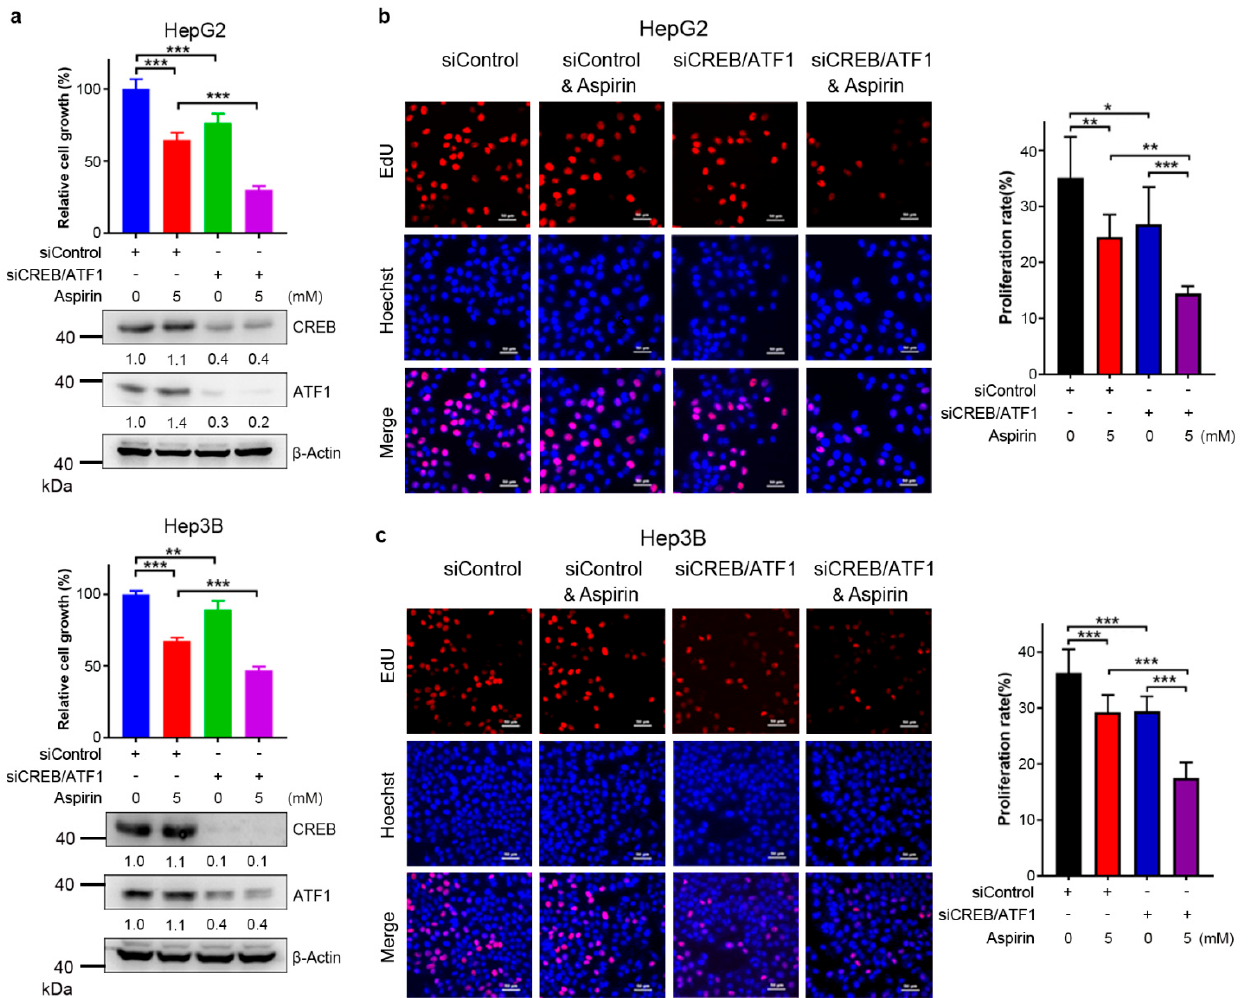
Figure 4. CREB/ATF1 knockdown sensitizes HCC cells to aspirin. ( a ) HepG2 and Hep3B cells were transfected with siControl or siCREB/ATF1 and treated with or without aspirin for 48 h, followed by CCK-8 assays. The relative cell growth was plotted. Values represent means ± SD ( n = 5). ***, p < 0.001. The efficiency of CREB and ATF1 knockdown was detected by Western blotting. ( b , c ) HepG2 and Hep3B cells were transfected with siControl or siCREB/ATF1 and treated with or without aspirin for 48 h, followed by detecting proliferative cells with EdU assays. In addition, all cells were labeled with Hoechst33258. The proliferation rate was plotted. Values represent means ± SD ( n = 3). *, p < 0.05, **, p < 0.01, ***, p < 0.001.